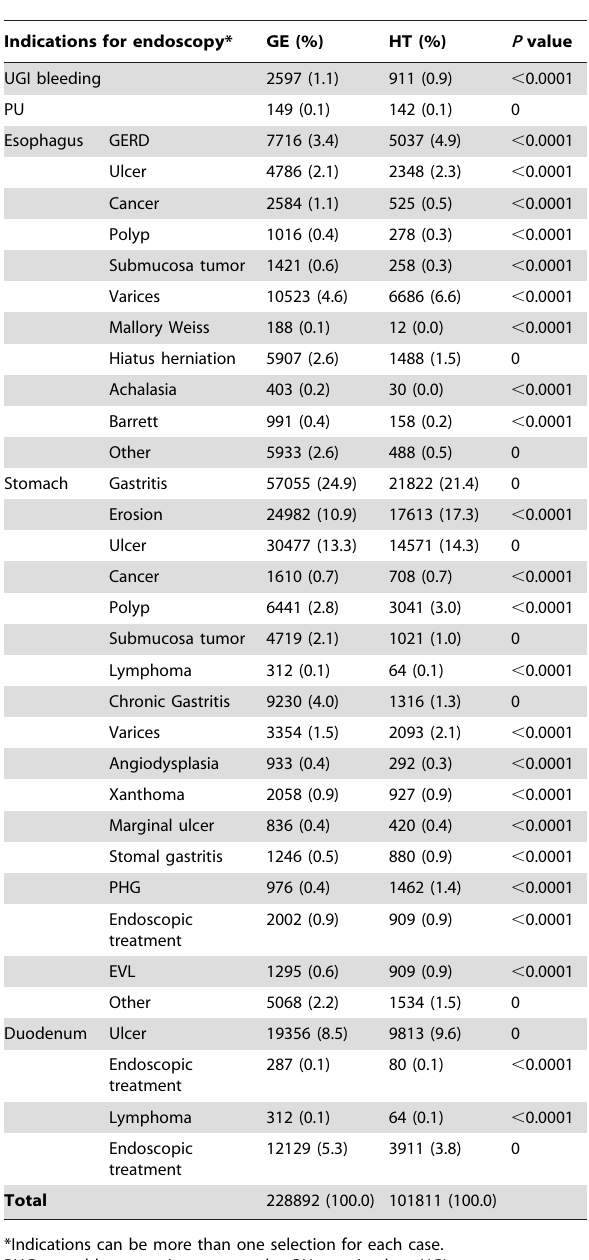
Table 1. Indications for upper endoscopies for the gastroenterologists and